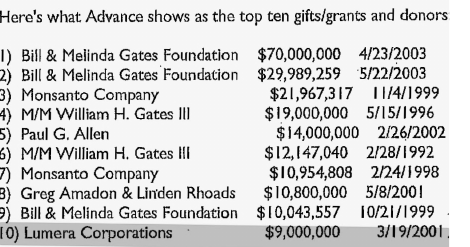
Figure 5: Top ten gifts to the UW. Email from W. Dryfoos to C. Kravas et al. 2003, Jan 4.